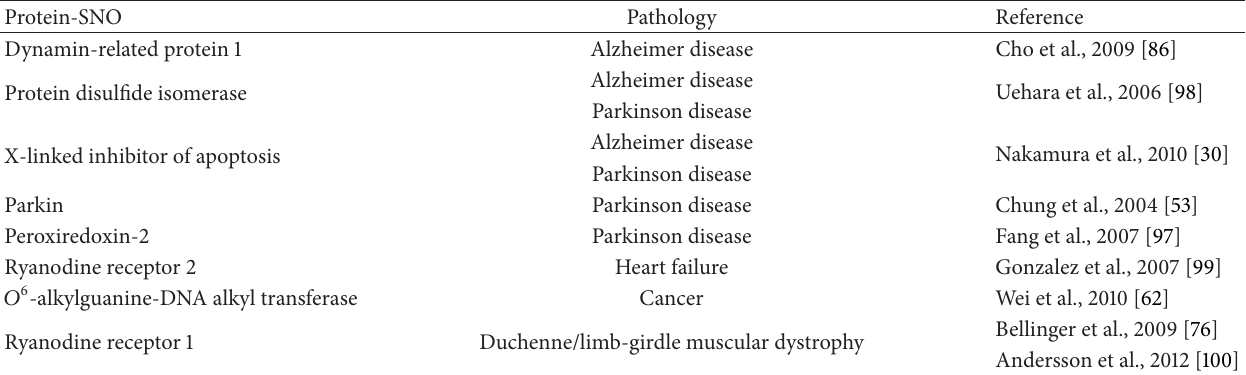
Table 1: Examples of pathological conditions associated with alterations in